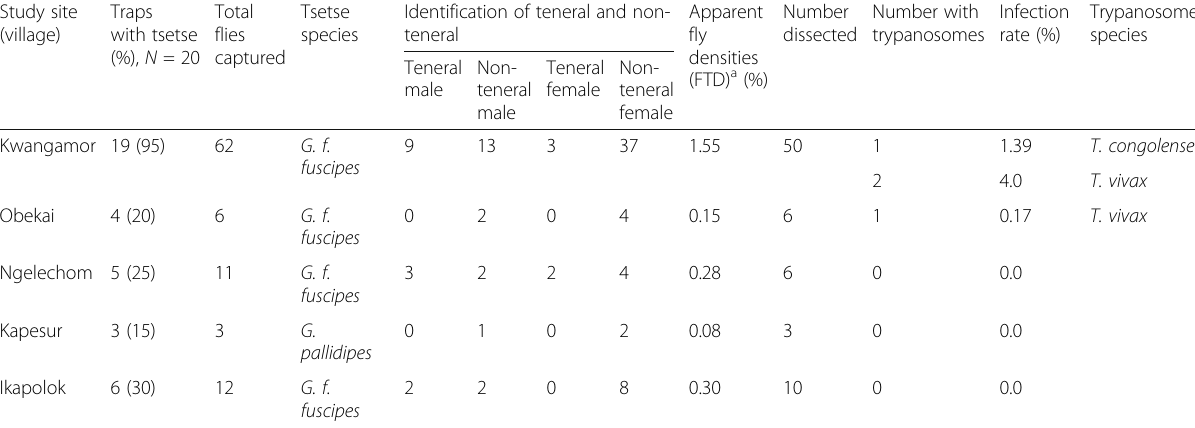
Table 1 Summary of tsetse fly catches and Trypanosoma parasite positivity rates identified by dissection Study site Traps Total Tsetse Identification of teneral and non- (village) with tsetse flies species (%), N = 20 captured